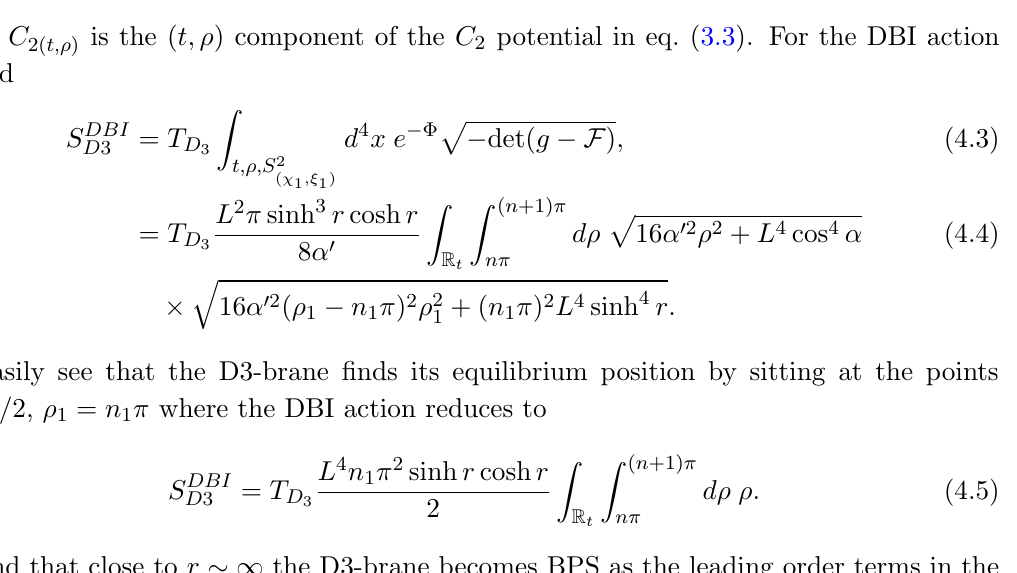
Figure 1 . Expanded D3-branes on 2-spheres with radii (cid:26) 1 = n 1 (cid:25)